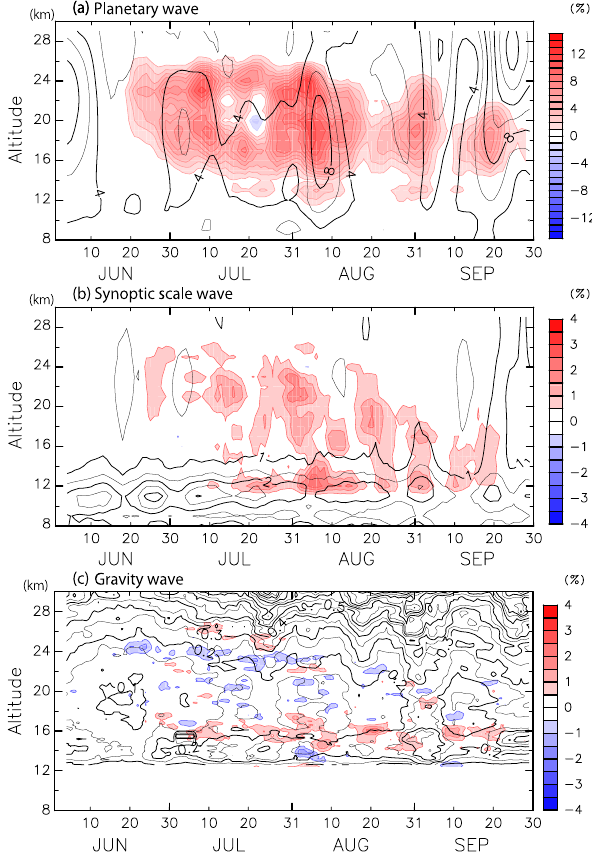
Fig. 10. Time-altitude sections of 5-day-runnning means for (a) 1R PW , (b) 1R SW and (c) 1R GW (color) in the latitude range of 55 ◦ S–70 ◦ S. A 500m-running mean is applied to 1R GW in the vertical direction. Contours indicate the zonal-mean and latitudinal- mean (55 ◦ S–70 ◦ S) standard deviation of temperature fluctuations due to the respective waves. Contour intervals are 2K for (a) , 0.5K for (b) and 0.05K for (c) .